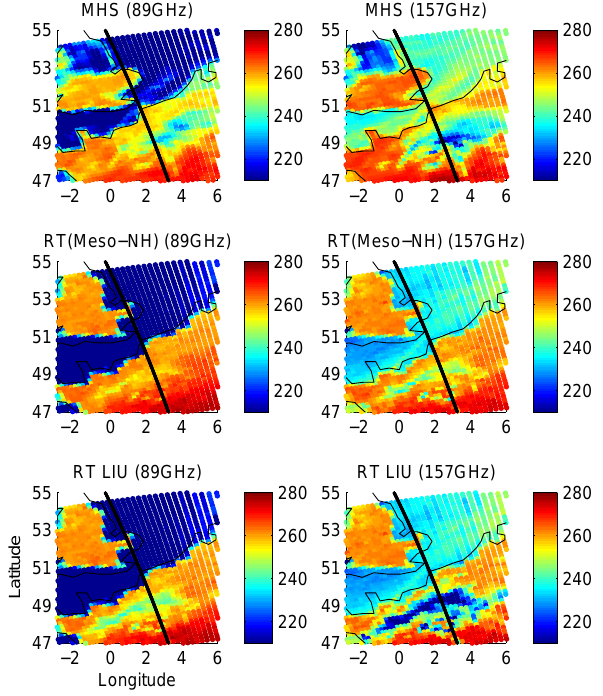
Figure 8. MHS observations at 89 and 157GHz (top panels), as compared to its radiative transfer simulations using the base- line configuration (i.e. assumptions intrinsic to the microphysical scheme of Meso-NH; middle panels), and the Meso-NH intrinsic scheme together with the Liu (2004) approximation and multiply- ing the snow quantities systematically by 1.25 (bottom panels). The solid black line illustrates the CloudSat